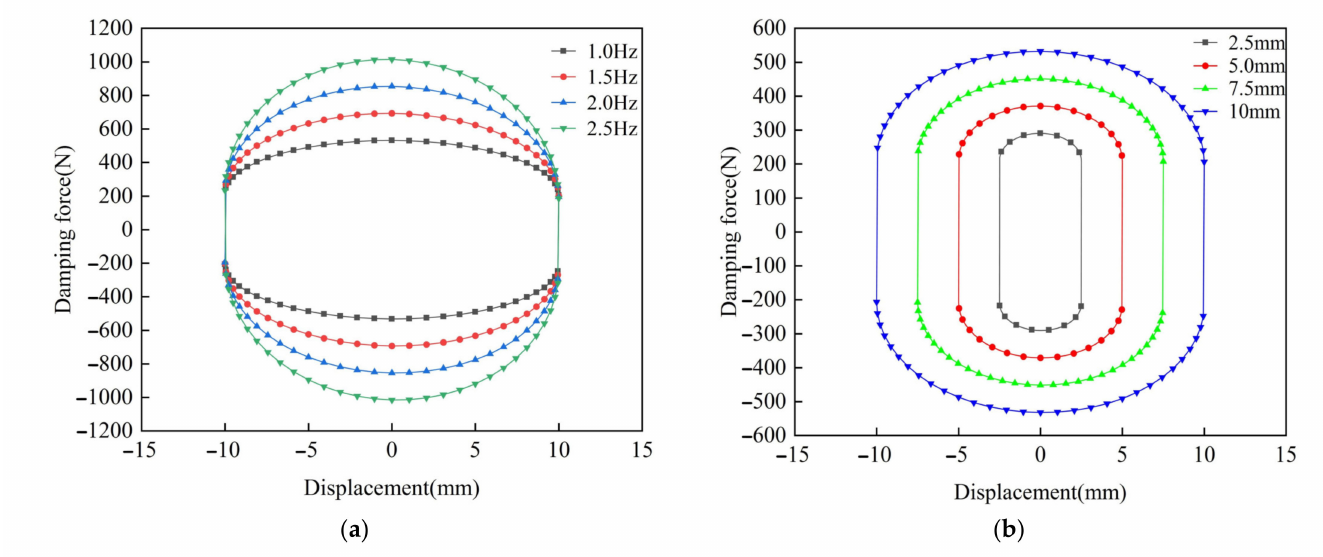
Figure 11. Force-displacement curves under different sinusoidal excitation simulation conditions. ( a ) Force-displacement curves under different frequency simulation conditions. ( b ) Force-displacement curves under different amplitude simulation conditions.